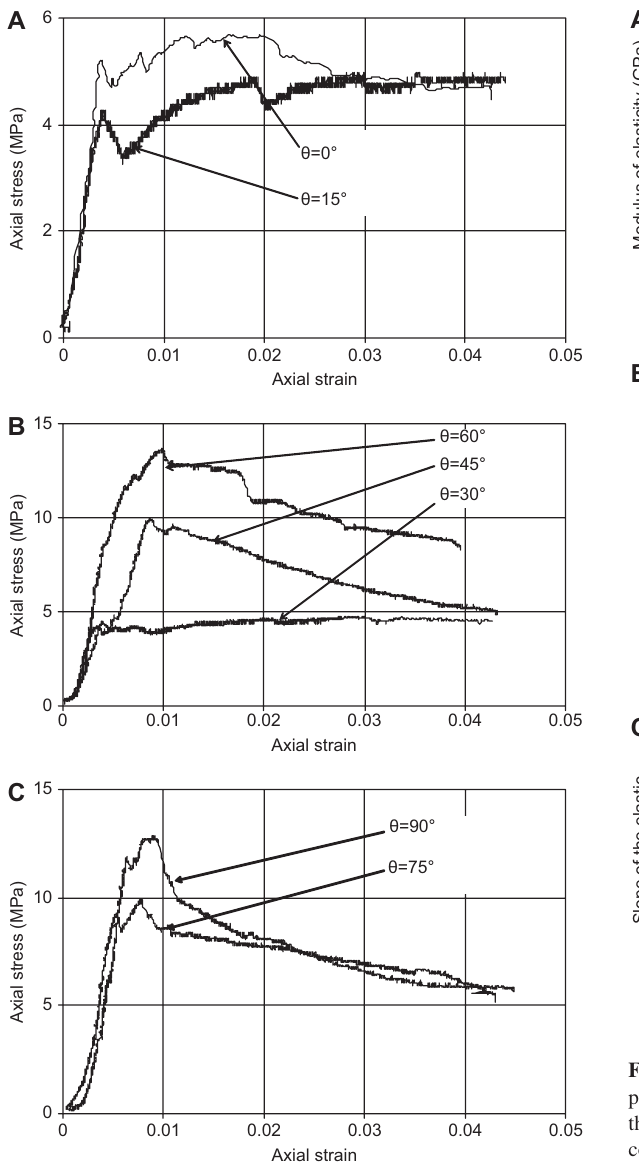
Figure 18 The axial stress-axial strain curves for the prismatic composite specimens for the whole range of tested inclinations of the adhesion plane.